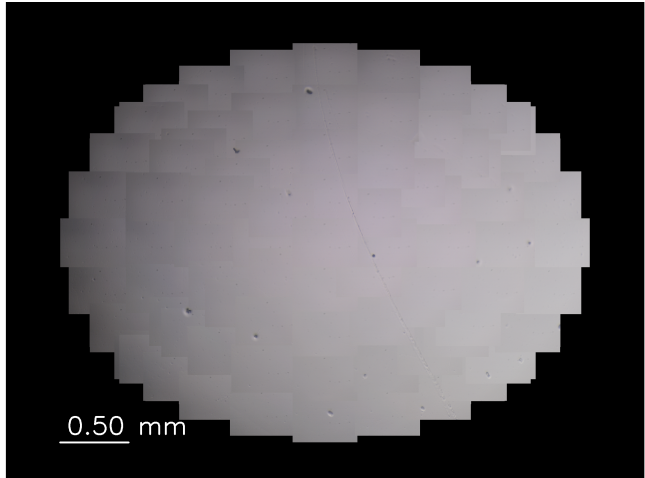
Figure 4. Magnified image with gamma